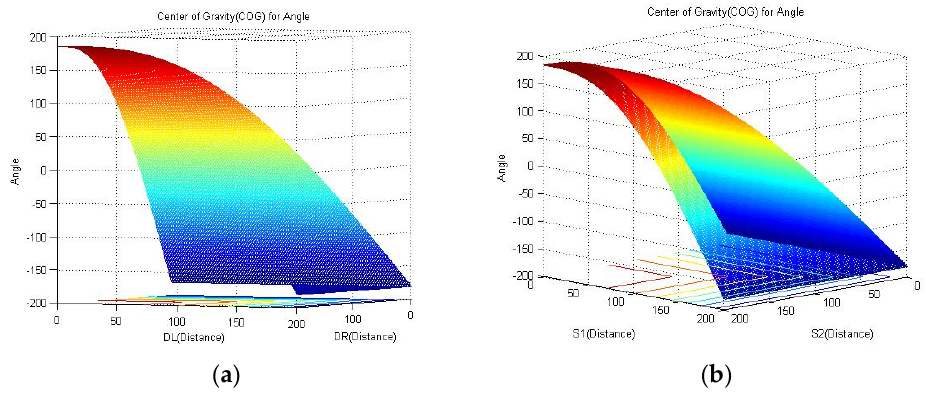
Figure 17. ( a ) Two input variables and one output variable of turning angles-1; ( b ) turning